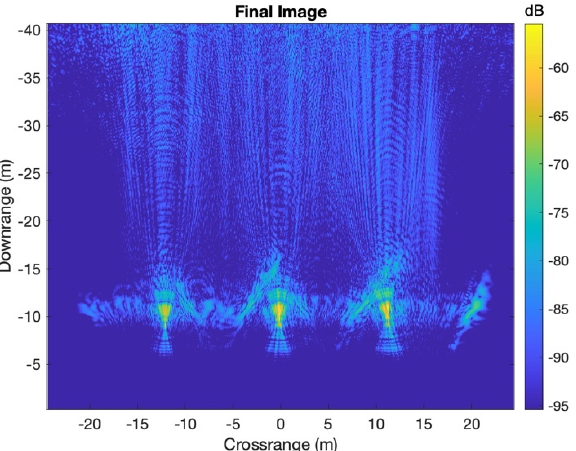
Figure 5. Radar image before correction.